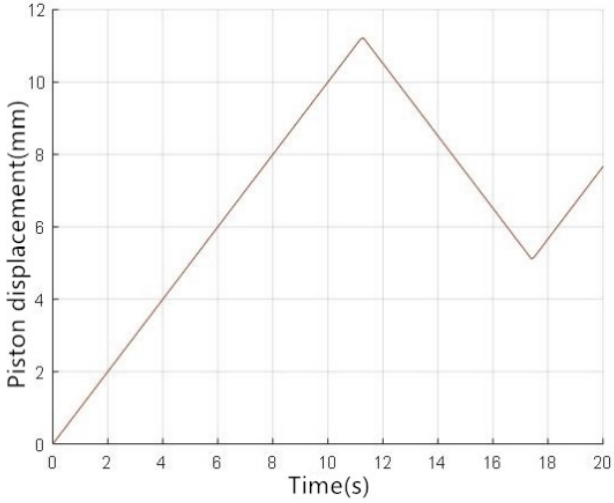
Figure 13. Piston displacement curve of PBC.